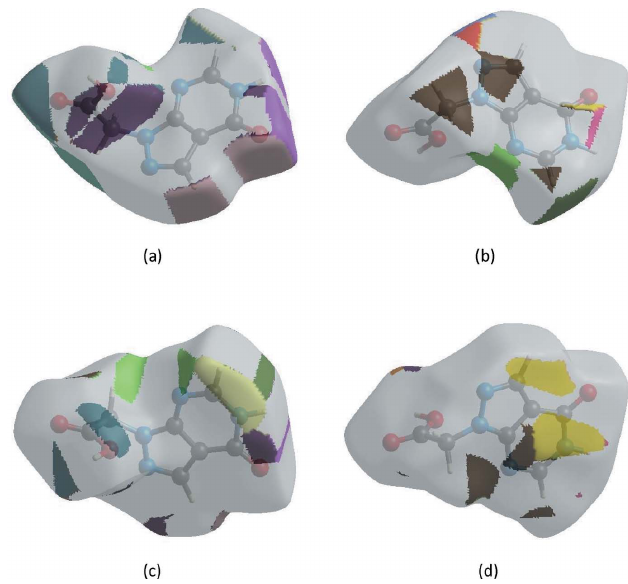
Figure 7 The Hirshfeld surface representations with the function d norm plotted onto the surface for ( a ) H (cid:2)(cid:2)(cid:2) O/O (cid:2)(cid:2)(cid:2) H, ( b ) H (cid:2)(cid:2)(cid:2) N/N (cid:2)(cid:2)(cid:2) H, ( c ) H (cid:2)(cid:2)(cid:2) H and ( d ) H (cid:2)(cid:2)(cid:2) C/C (cid:2)(cid:2)(cid:2) H interactions.